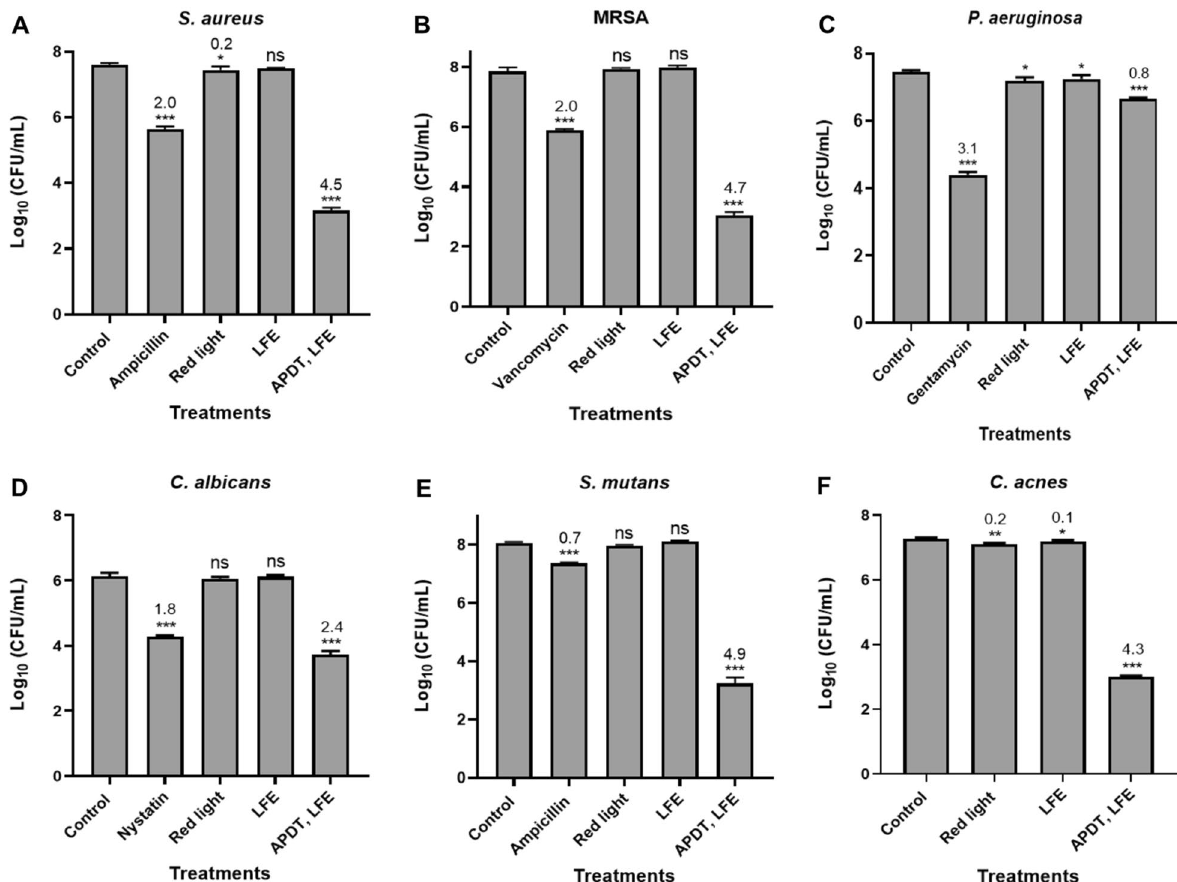
Fig. 2 In vitro antimicrobial activities of APDT with LFE against various pathogens. A APDT against S. aureus KCTC3881 (30 min incubation; red light intensity at 120 W/m 2 for 15 min), B APDT against MRSA (30 min incubation; red light intensity at 120 W/m 2 for 15 min). C APDT against P. aeruginosa (60 min incubation; red light intensity at 600 W/m 2 for 1 h). D APDT against C. albicans (60 min incubation; red light intensity at 600 W/ m 2 for 15 min). E APDT against S. mutans (30 min incubation; red light intensity at 120 W/m 2 for 15 min). F APDT against C. acnes (30 min incubation; red light intensity at 120 W/m 2 for 15 min). Suspensions of S. mutans , MRSA, S. aureus , and C. acnes were treated with LFE (20 µg/mL); P. aeruginosa and C. albicans were treated with LFE (50 µg/mL). Nystatin (20 µg/mL) and vancomycin or ampicillin (100 µg/mL) were used as positive controls. The data are expressed as mean standard error (n 2), and representative of at least two independences. ns indicates no statistical significance ± = relative to the control group. Significant differences are expressed with * for p < 0.05, ** for p < 0.01, and *** for p < 0.001 relative to the vehicle control. The log reductions compared with vehicle control are presented in each